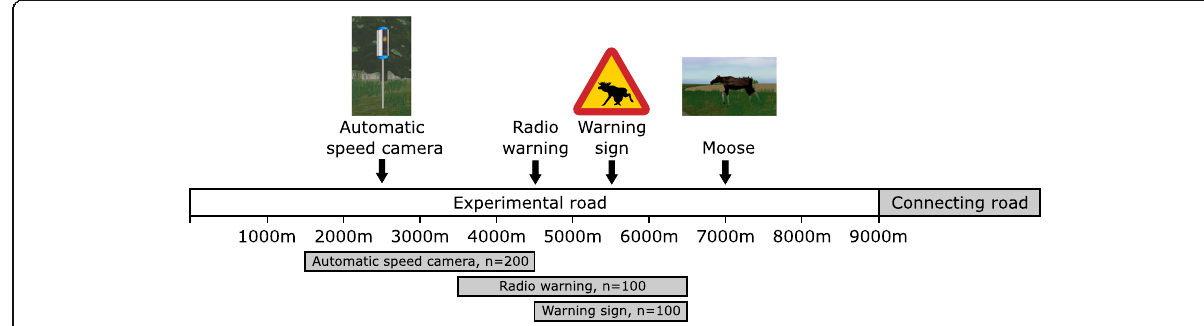
Fig. 2 Road layout for stretches used in the study. The automatic speed camera was located at 2500 m. It was preceded by an “ E24 ” sign at 2200 m that informs drivers about the upcoming speed camera. The radio warning was presented at 4500 m, a wildlife warning sign (moose) at 5500 m, and the moose was located at 7000 m after the start. The road stretches also included the variables wildlife fence/no wildlife fence and dense forest or open landscape, not shown here (see Fig. 3). Note that the variables were included in a factorial manner for each road stretch (not all at once). The range of the data surrounding each event, and the number of cases included in the analyses, are illustrated at the bottom